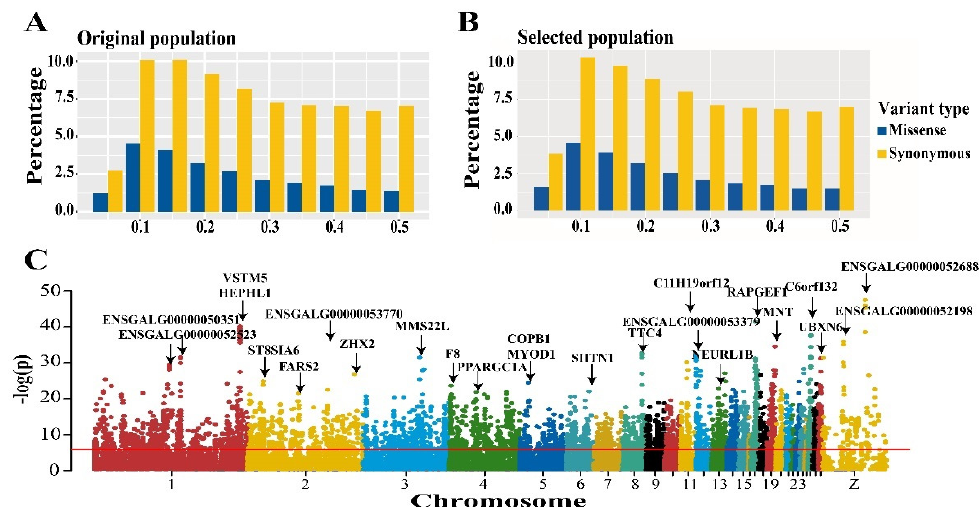
Figure 2. Analysis of allele spectrum and frequency difference of missense and synonymous SNPs. ( A , B ) Minor allele frequency spectrum of missense and synonymous SNPs in original and selected population. ( C ) Manhattan plot of frequency difference of missense variants between two lines, the y -axis represents the p value in log scale, which calculated by Fisher’s exact test, the x -axis represents the physical position of missense SNPs in each